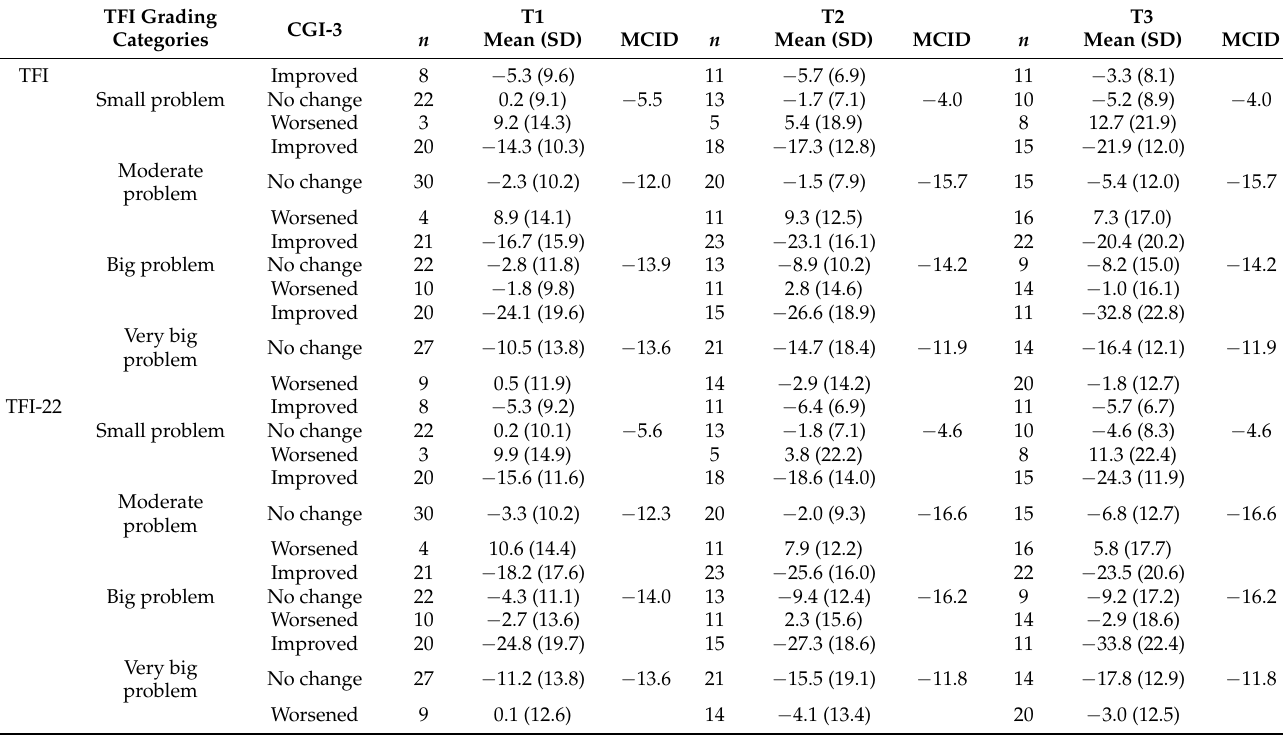
Table 3. Mean (SD) TFI and TFI-22 global scores according to the Clinical Global Impression (CGI) categories stratified by TFI grading categories and the Minimal Clinically Important Difference (MCID) estimates for ‘improved’ at follow-up